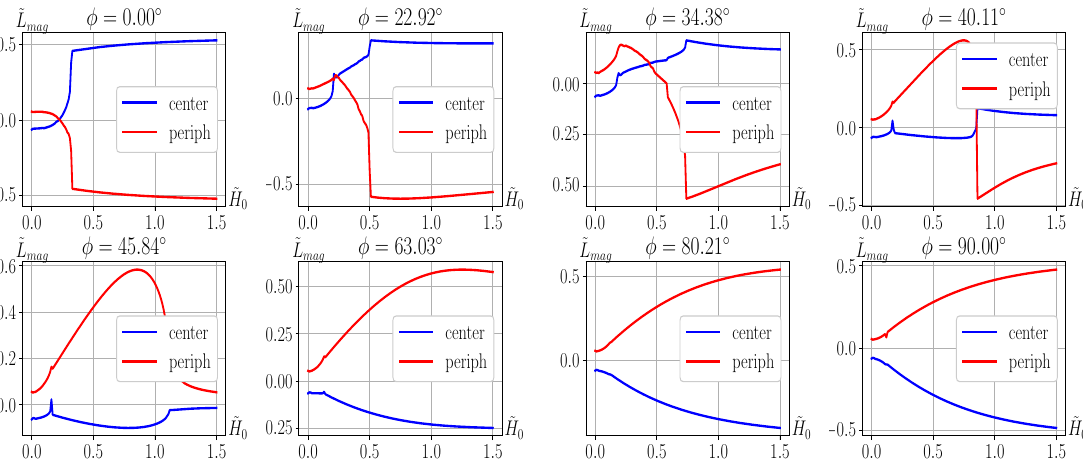
Figure 4. Mass magnetic moments at different angles φ to the y axis, the blue color shows the moment for element 1 2 (the middle area in Figure 3), red for element 2 − The dependence of ˜ L mag on ˜ H 0 , shown in Figure 3 for angle φ = 45.84 ◦ , allows us